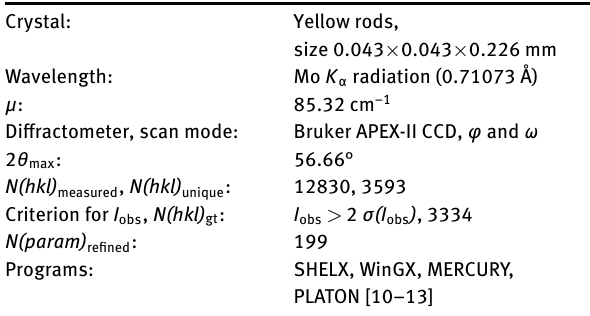
Table 1: Data collection and handling.